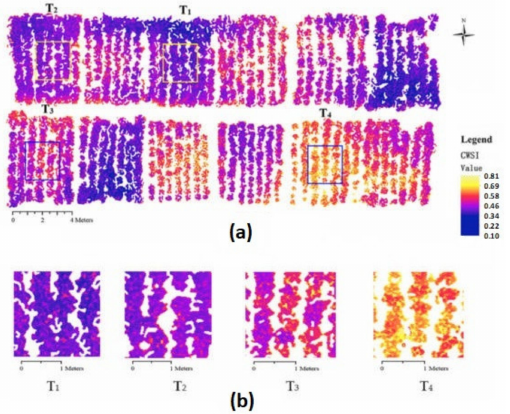
Figure 3. ( a ) Map of CWSIsi measured at 13:00 [32]; ( b ) Map of CWSIsi for specific zones inside the T1, T2, T3 and T4 plots